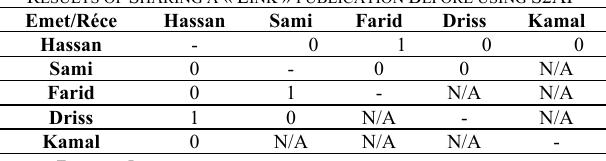
TABLE VII R ESULTS OF S HARING A « L INK » PUBLICATION B EFORE USING S2AF